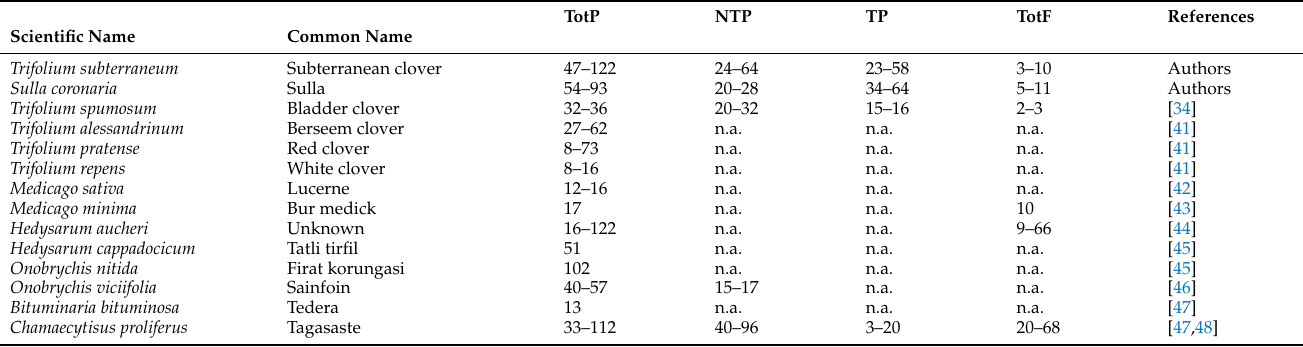
Table 3. Total phenolics (TotP), non-tannic phenolics (NTP), tannic phenolics (TP), and total flavonoids (TotF) in different legume species (mg g − 1 DM). TotP NTP TP TotF